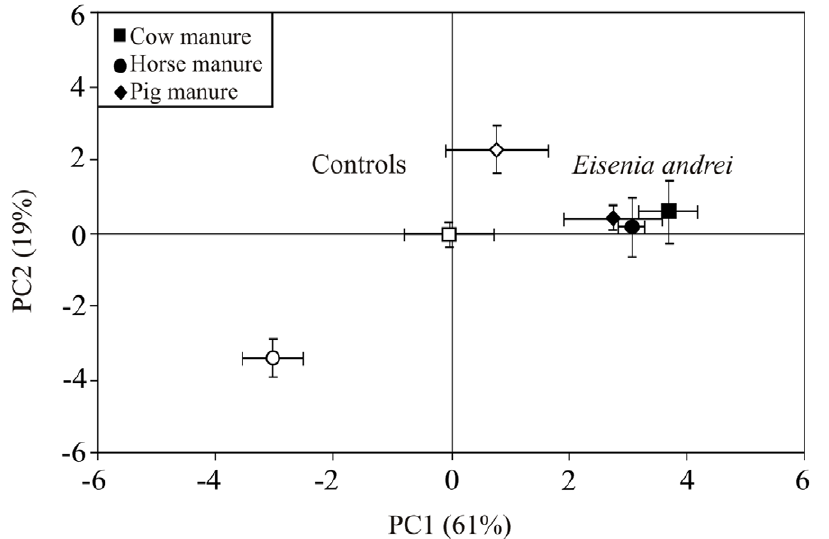
Figure 2. Changes in microbial community structure after the passage of the three different animal manures (cow, horse and pig) through the gut of the earthworm species Eiseniaandrei . Principal component analysis performed on the twenty-seven PLFAs identified in cast (filled symbols) and control (open symbols) samples derived from the different animal manures. The first and second principal components (PC1 and PC2) explain 61 and 19% of the variance respectively. Values are means 6 SE. Controls are the manures incubated without earthworms.